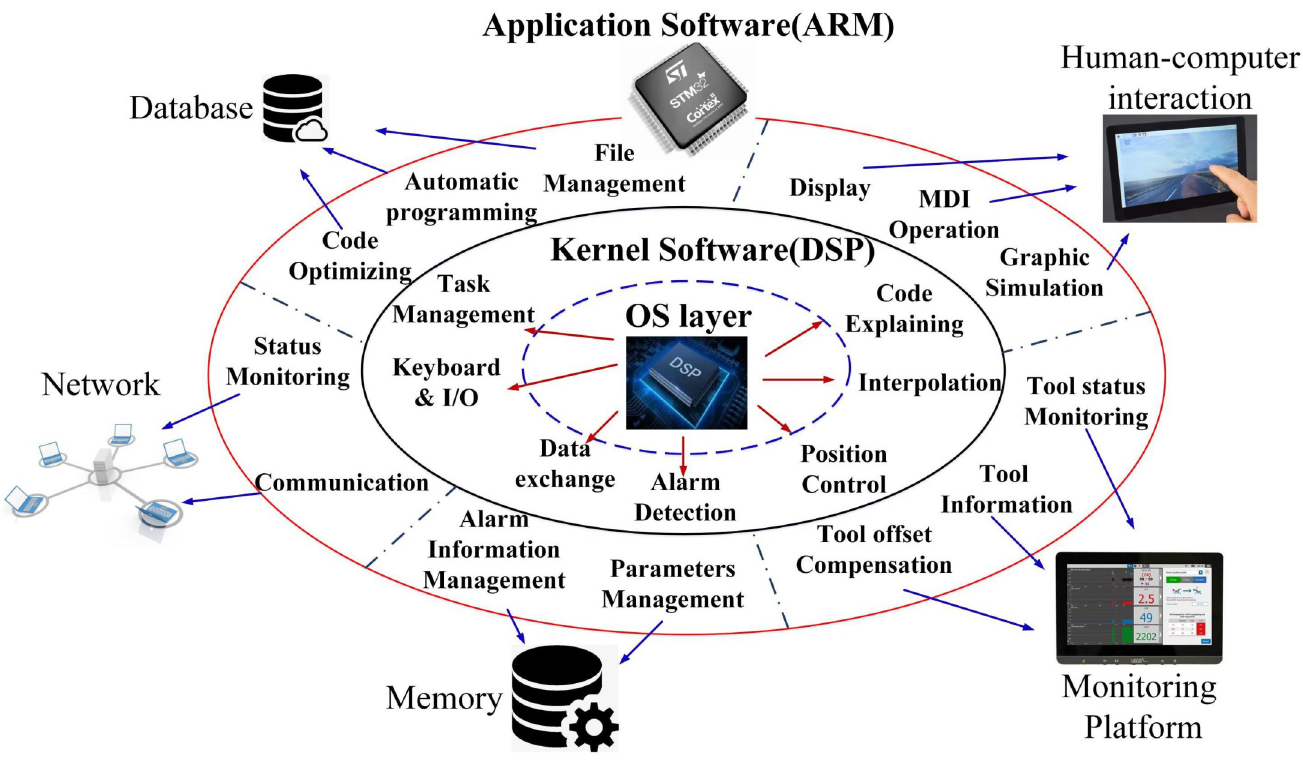
Fig 4. "ARM+DSP" system division. https://doi.org/10.1371/journal.pone.0264285.g004 As shown in Fig 5, SPI uses a Master-Slave control method and a timing synchronized data transfer method. The master device generates the clock signal to work synchronously with the slave device [35]. The meaning of each component is: SSPBUF is the internal buffer of SPI